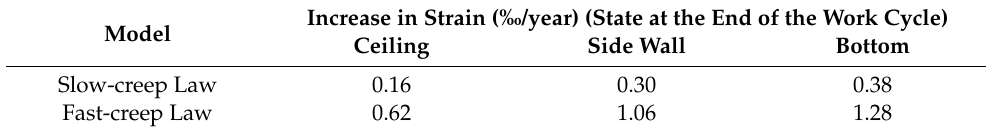
Table 10. Annual increase of effective